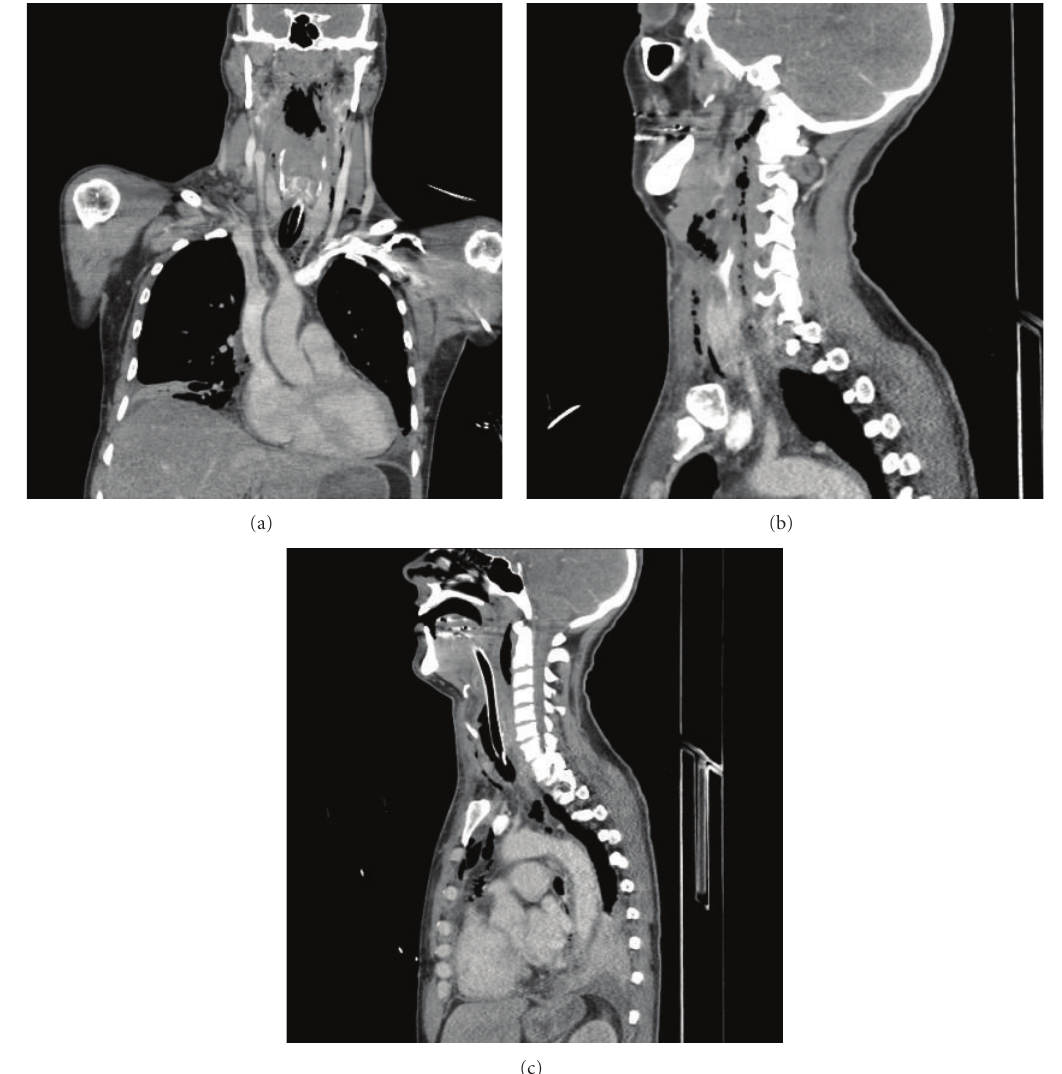
Figure 1: Coronal and sagittal CT scans demonstrating free gas from the skull base through the neck and into the anterior and posterior